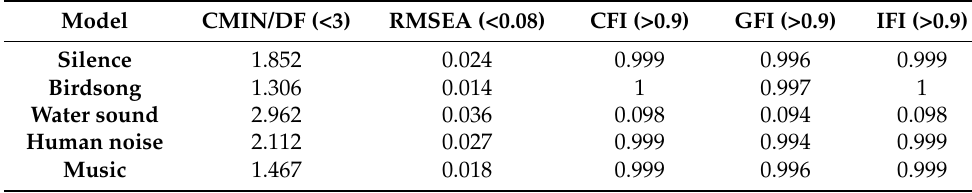
Table 4. The fitting degree index of the models under different scenarios. Table 5. Standardized direct effects of environmental characteristic on mental restoration